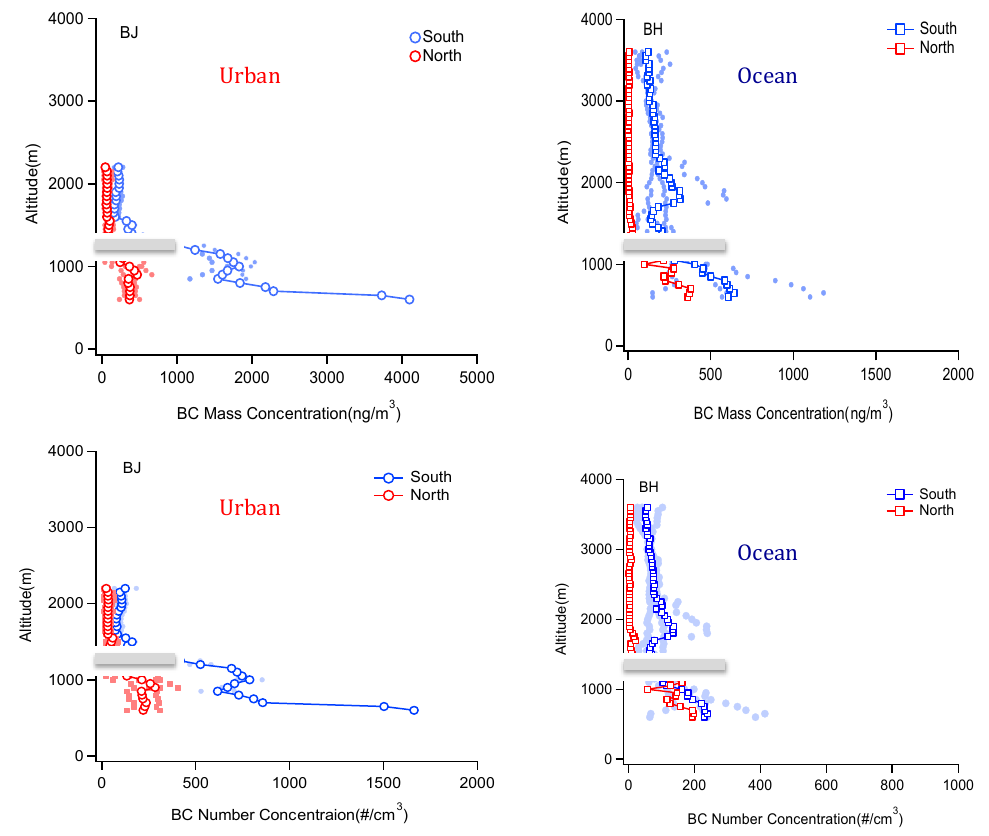
Figure 5. The rBC vertical distributions in two very different areas under different air mass directions. One is an urban location (BJ) that represents a very polluted case (left panels), and the other is an ocean location (BH) that represents a remote area (right panels). The red color shows the northern air mass, and the blue color shows the southern air mass. The horizontal gray bars showed the height of the